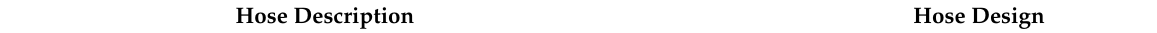
Table 1. Showing some Floating and Submarine Hoses with pressure ratings (Hose Courtesy of EMSTEC).